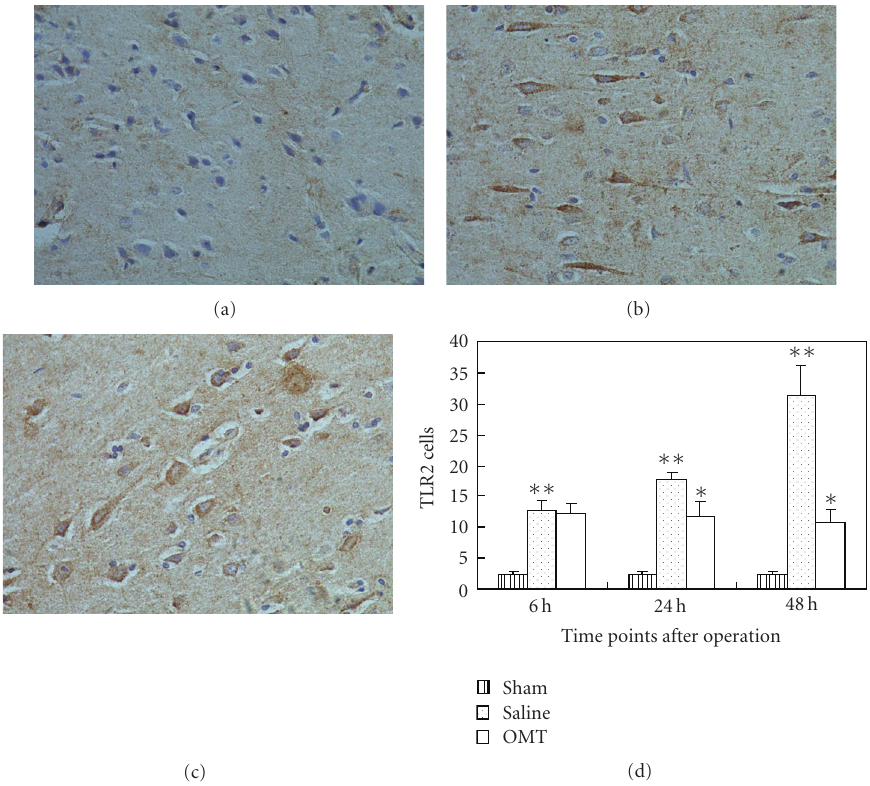
Figure 7: TLR2 expression detected by immunohistochemistry. (a) TLR2 expression in the sham group: TLR2 expression could be observed periodically in the sham group at 24 hours. (b) TLR2 expression in the saline group: TLR2 expression evidently increased in the saline group at 24 hours. Positive cells were defined as presenting bu ff y grains in cytoplasm. (c) TLR2 expression in the OMT treatment group: TLR2 expression decreased relatively in the OMT treatment group at 24 hours. (d) TLR2 expression in each group at all time points: expression of TLR2 protein was evidently higher in the saline group at 6 hours and lasted up to 48 hours. There was no di ff erence between saline and OMT group at 6 hours. Compared with the saline group at 24 hours and 48 hours, expression of TLR2 protein was lower in the OMT treatment group, and the di ff erence was significant ∗∗ P < . 05 compared with Sham and ∗ P < . 05 compared with saline